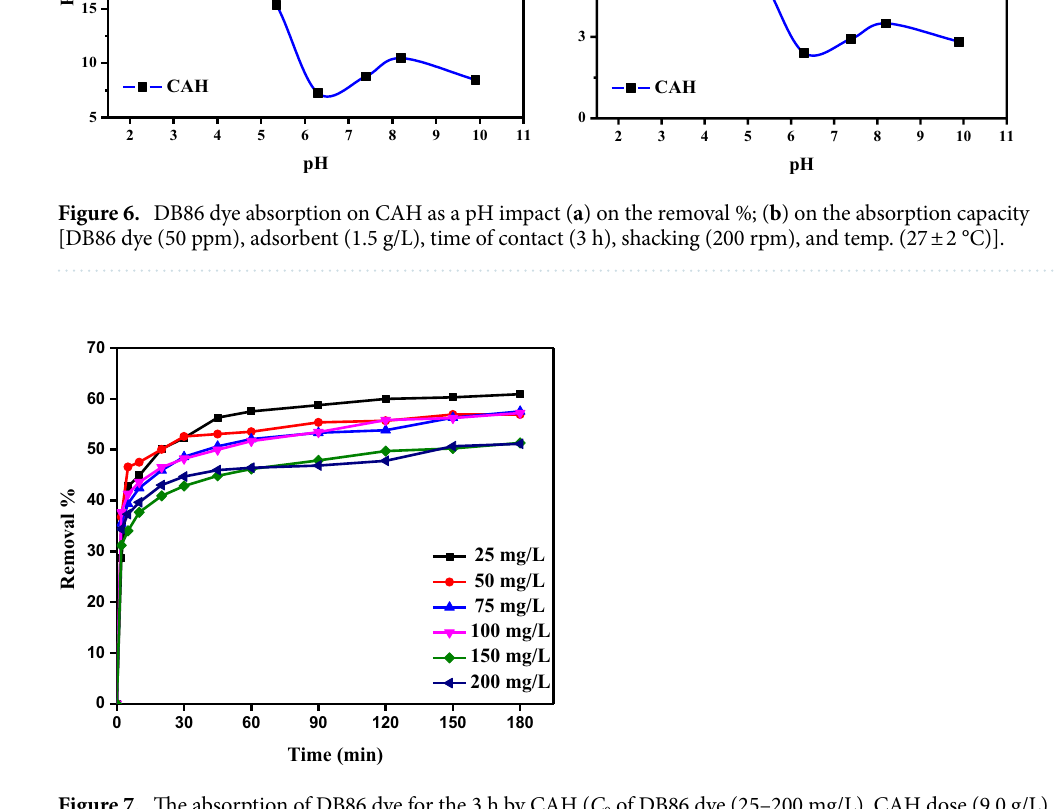
Figure 7. The absorption of DB86 dye for the 3 h by CAH ( C 0 of DB86 dye (25–200 mg/L), CAH dose (9.0 g/L), temp. (25 ± 2